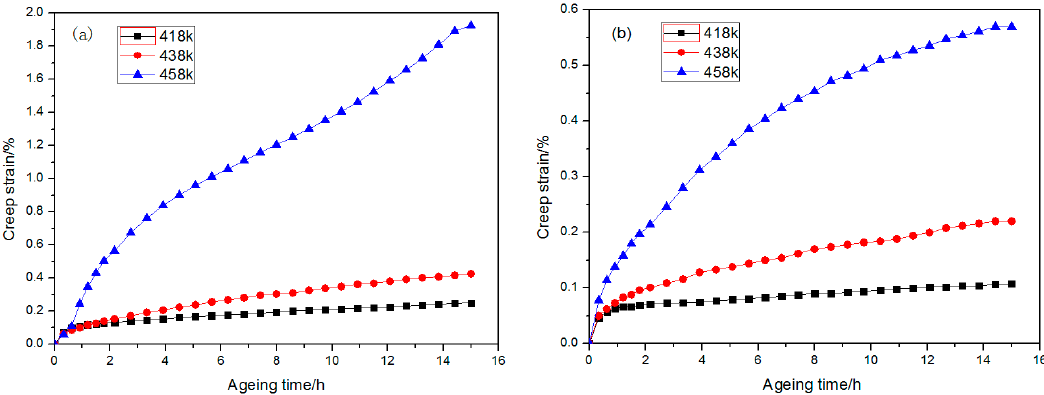
Figure 2. Creep curves of 2219 aluminum alloy at different experimental temperatures under the same stress. ( a ) 150 MPa; ( b ) 130 MPa.